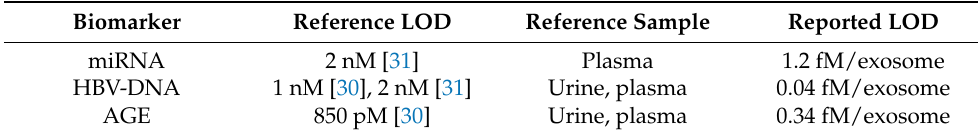
Table 1. Comparison with optical assays for biological biomarkers in biological fluids. Biomarker Reference LOD Reference Sample Reported